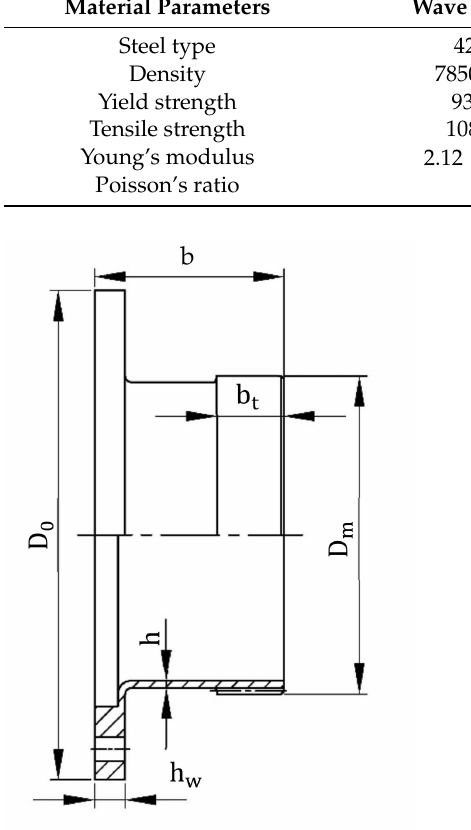
Figure 5. Structure parameters of the